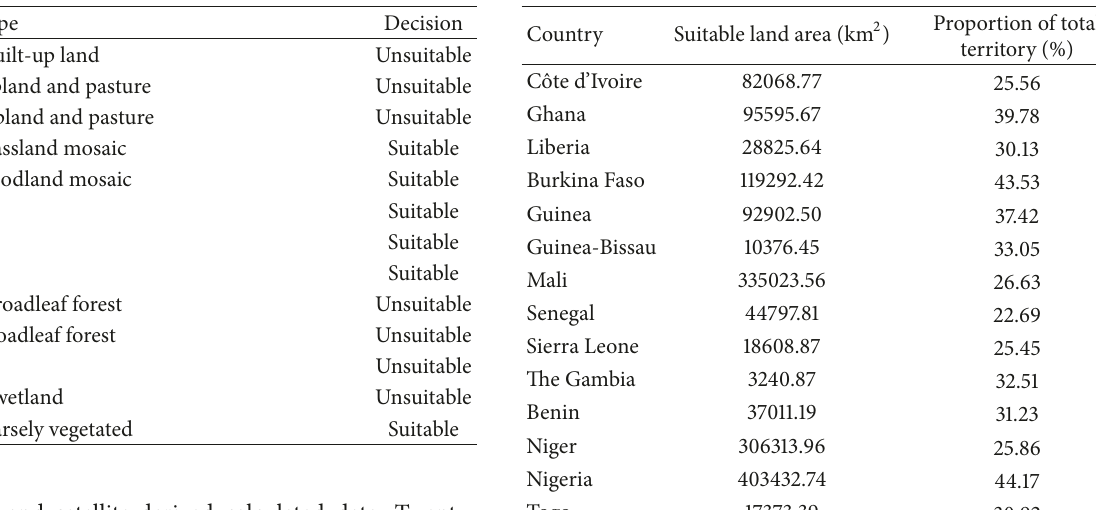
Table 1: Land cover type and criteria for PV technologies. Table 2: Potential area of PV